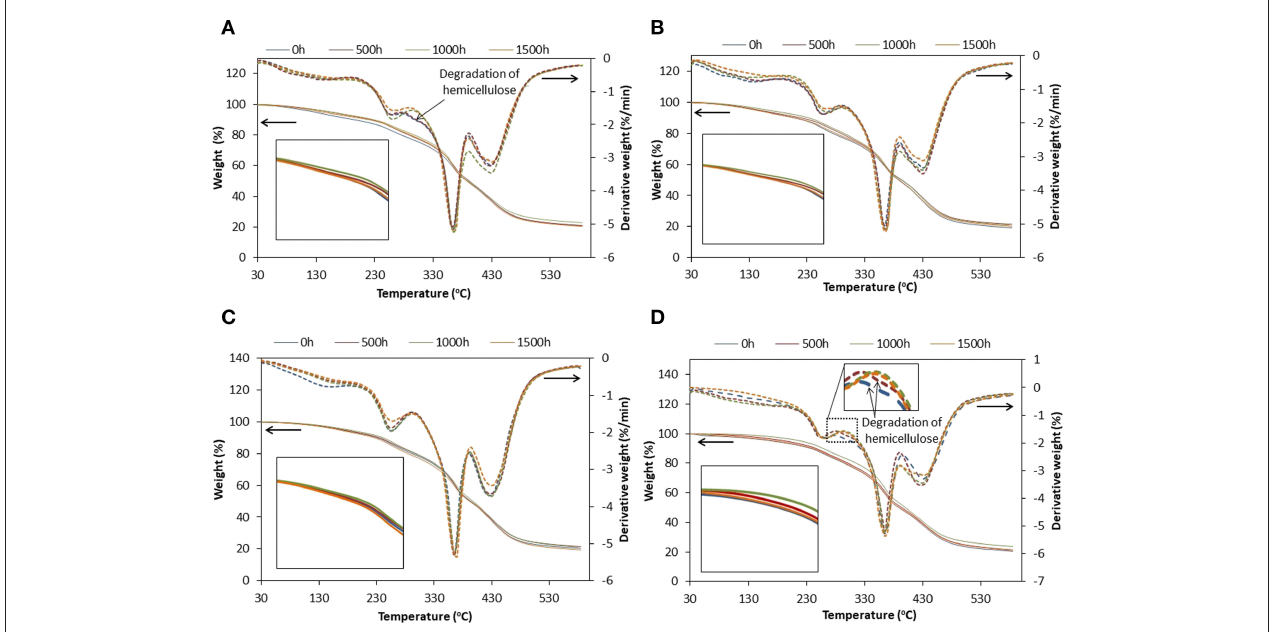
FIGURE 6 | TGA and DTG curves of composites after accelerated weathering exposure (A) UTKC, (B) ATKC, (C) AHTKC, and (D) HTKC.